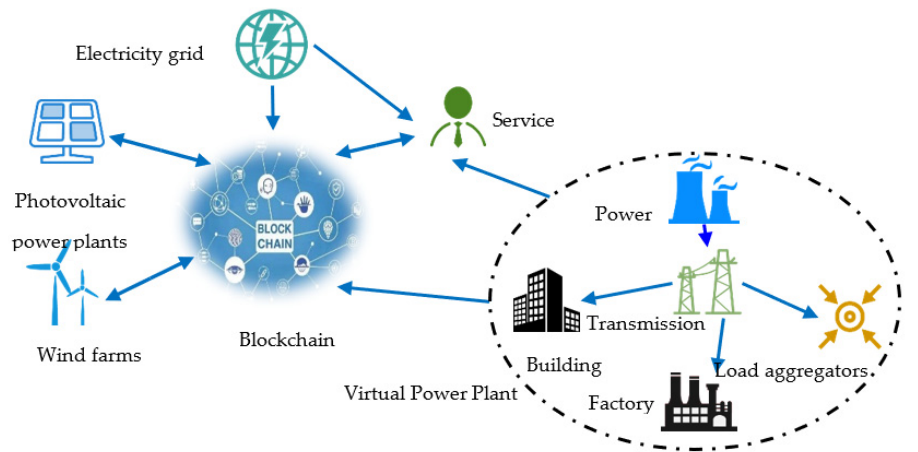
Figure 1. Application of the blockchain technology in power